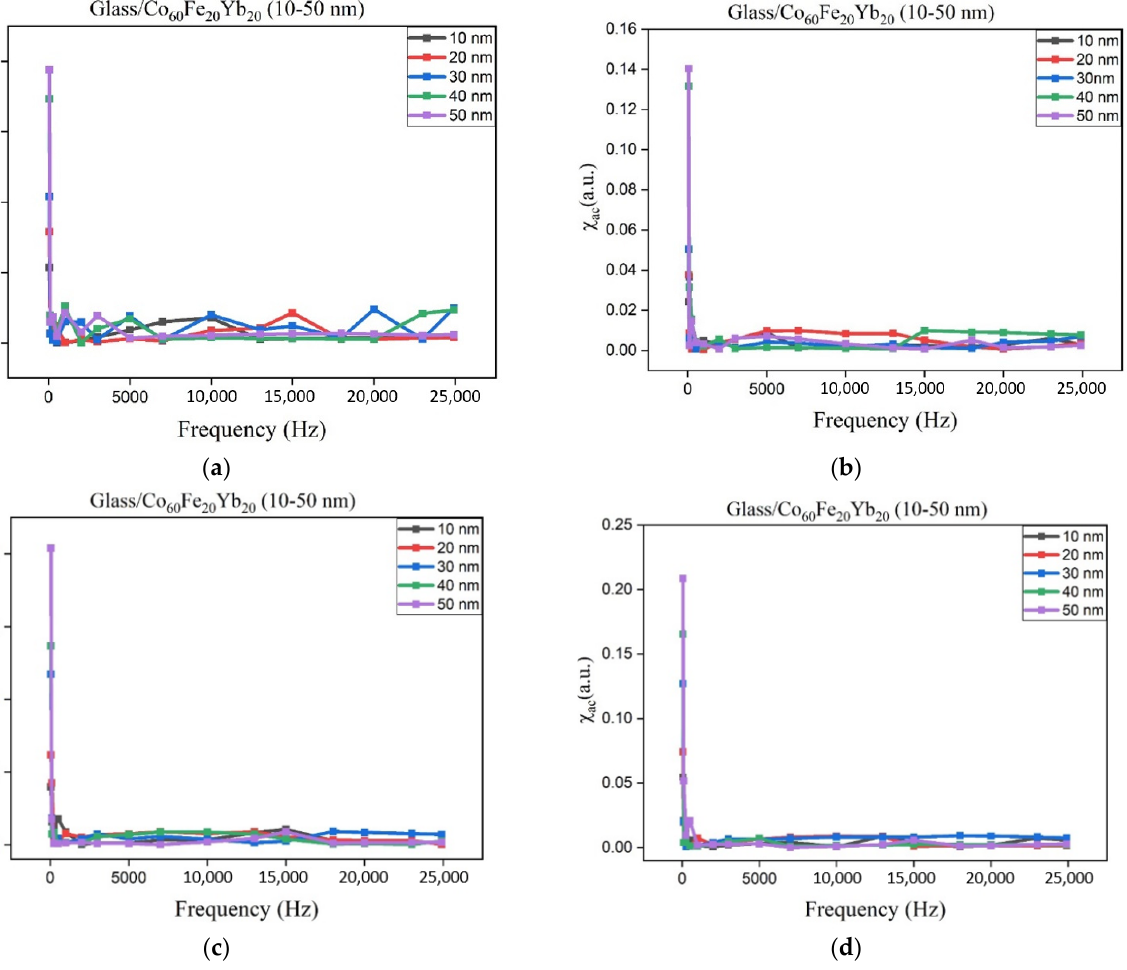
Figure 2. The relationship between the low-frequency alternate-current magnetic susceptibility ( χ ac ) and frequency, from 50 to 25,000 Hz. ( a ) RT, ( b ) following annealing at 100 °C, ( c ) following annealing at 200 °C, and ( d ) following annealing at 300 °C.